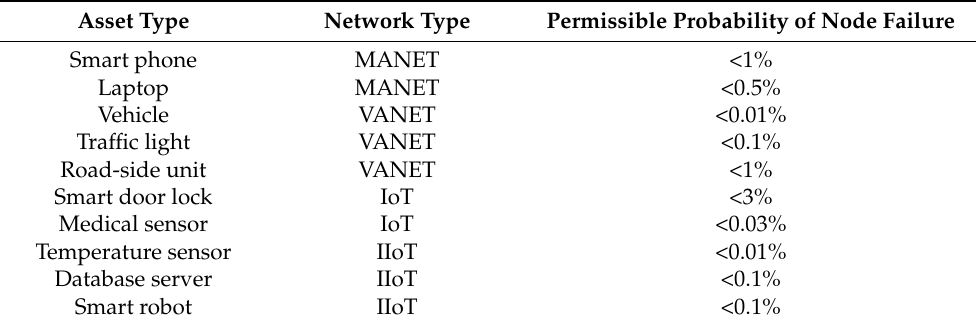
Table 2. The thresholds for the unacceptable